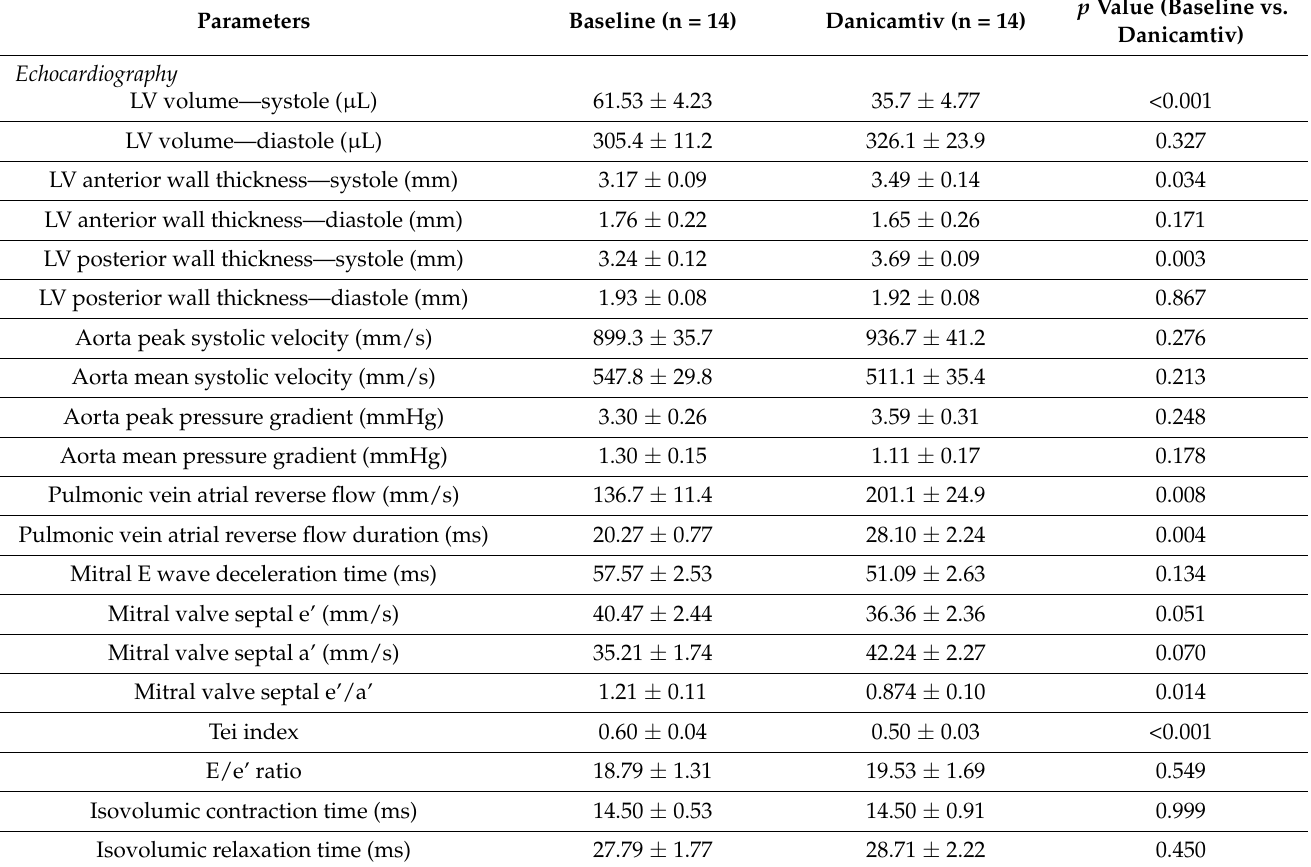
Table 1. Echocardiographic and electrocardiographic parameters measured at baseline and following danicamtiv administration in